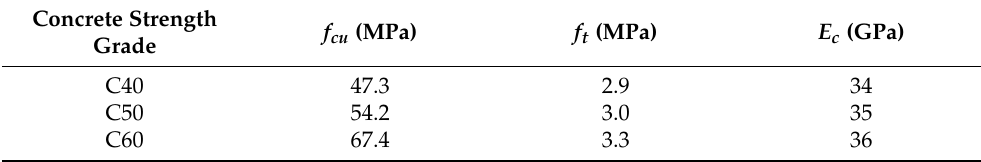
Table 4. Measured mechanical properties of concrete.